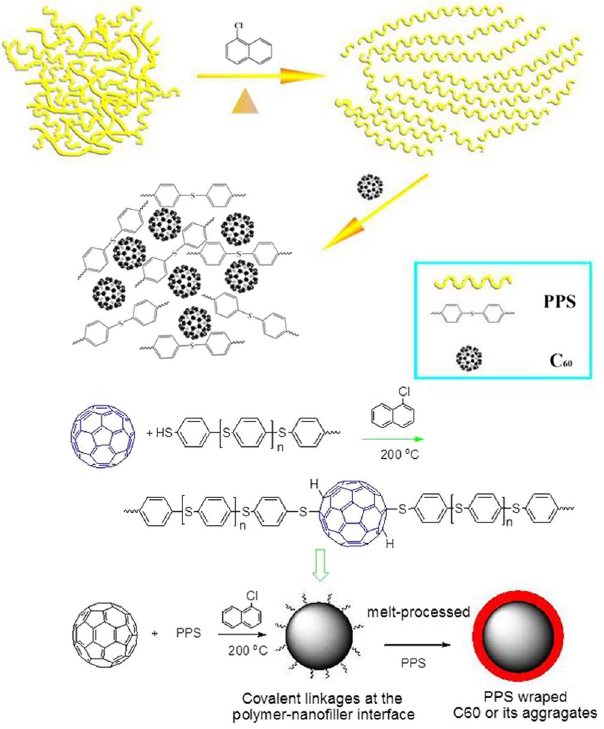
Figure 6. The chemical functionalization process of fullerenes and PPS/C 60 interfacial adhesion changes during solution and melt processing.